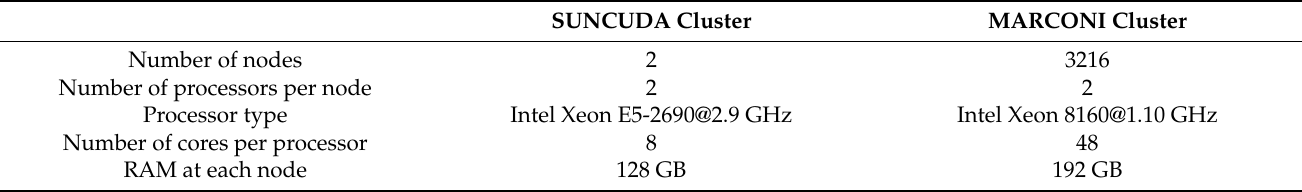
Table 1. Features of the adopted parallel